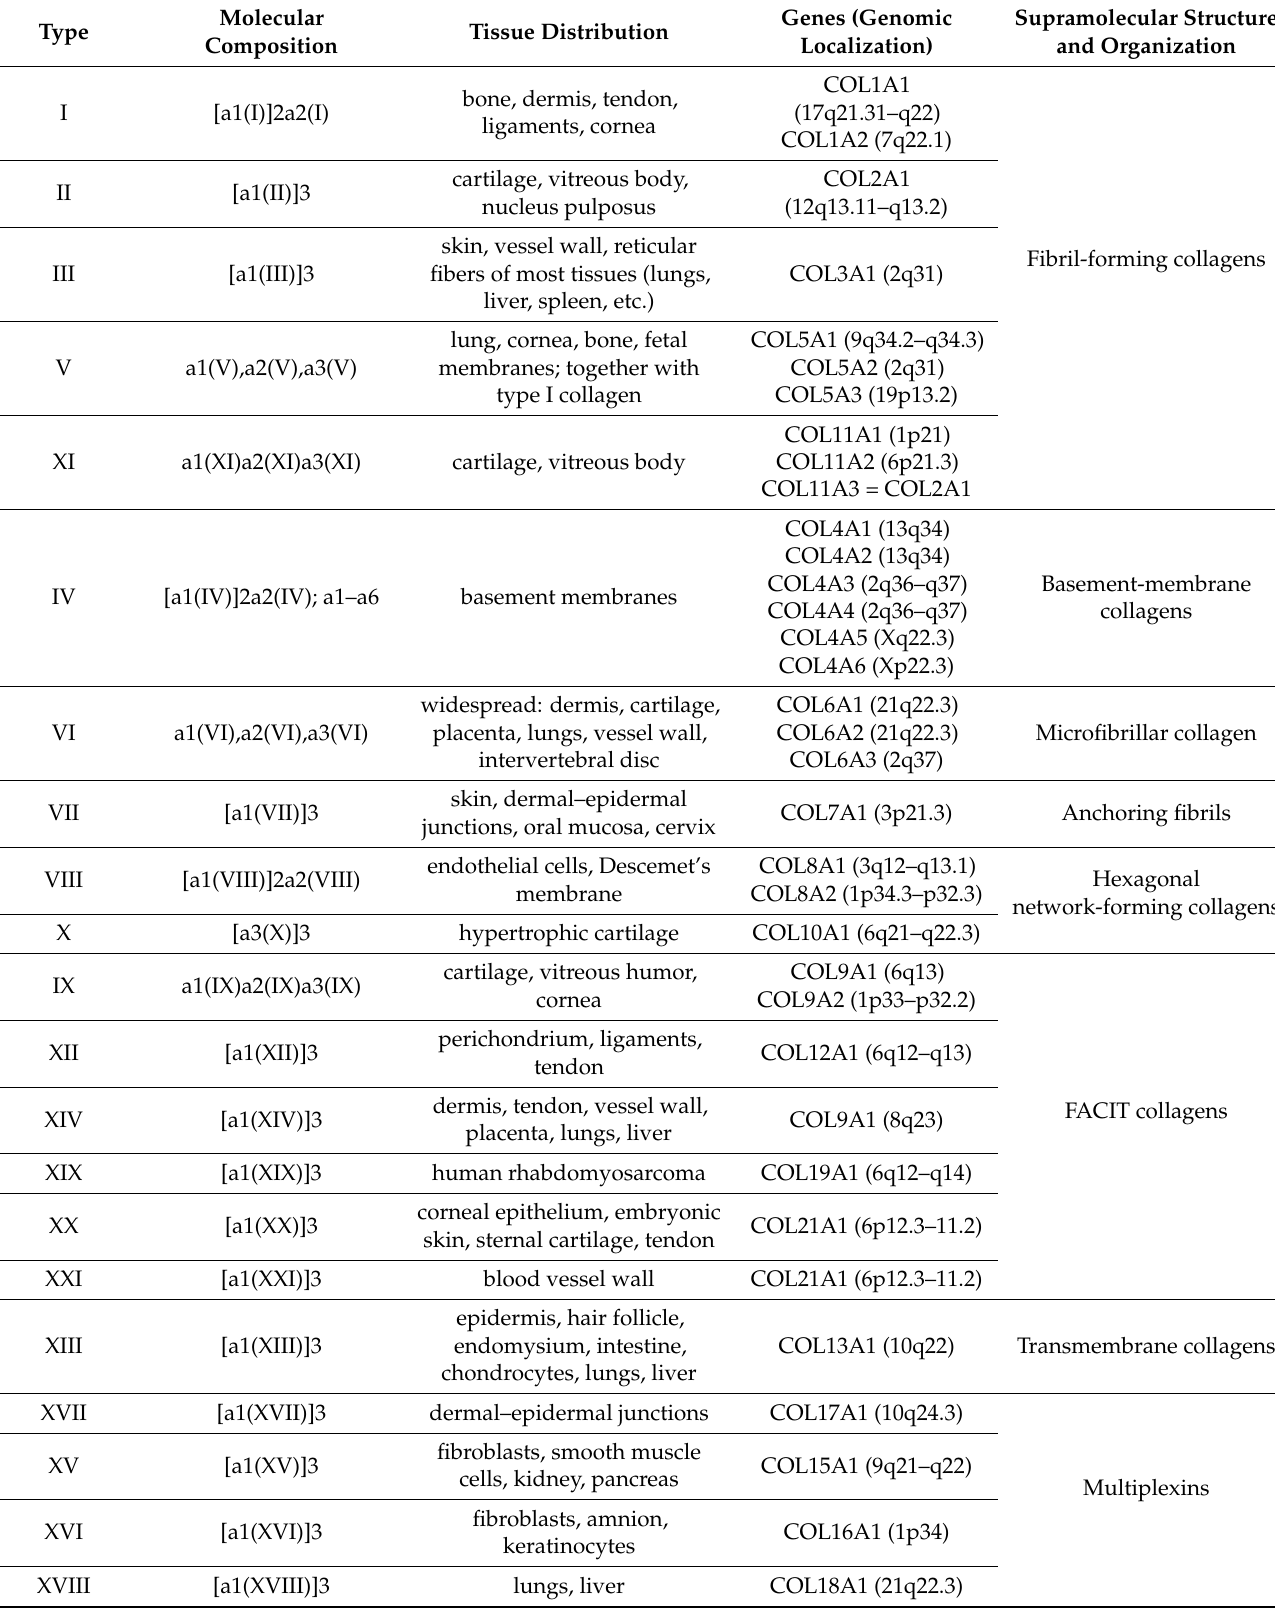
Table 1. Classification of collagens according to their molecular